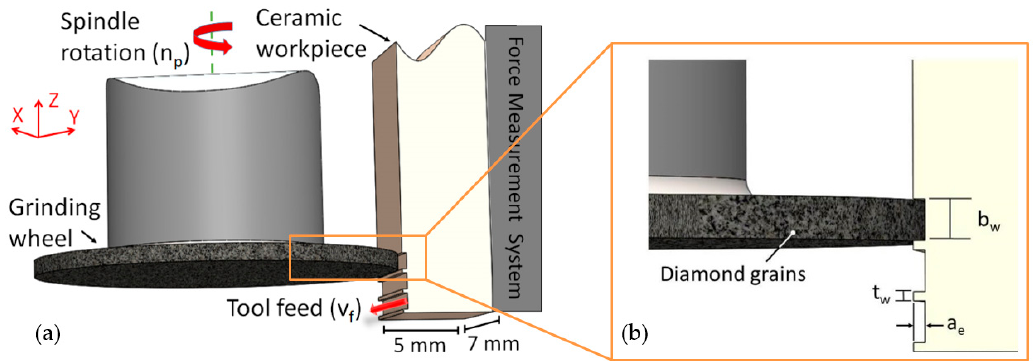
Figure 2. Illustration of the micro-grinding strategy performed in this work ( a ) in which the tool engagement and the workpiece features are highlighted ( b ). Table 2. Grinding conditions and material selection.